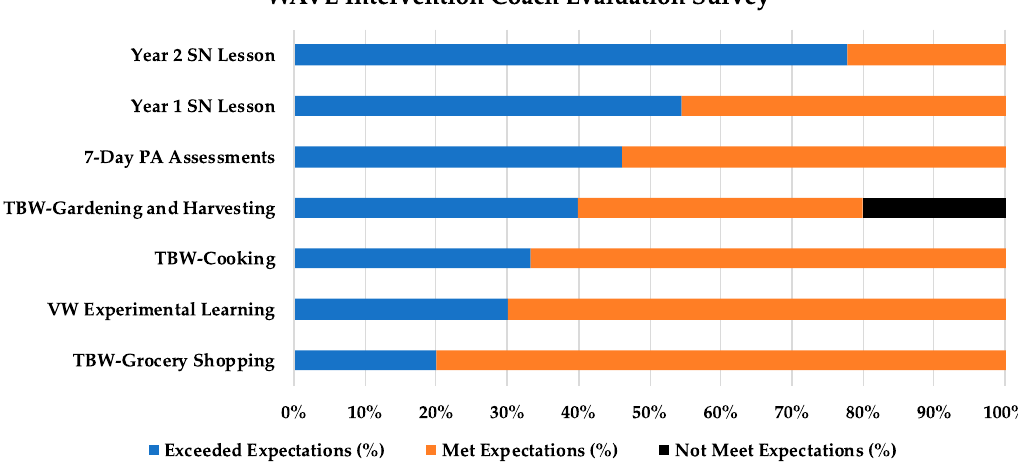
Figure 4. Coach rating of WAVE intervention activities. TBW: team-building workshop; SN: sports nutrition; PA: physical activity; VW: virtual world.